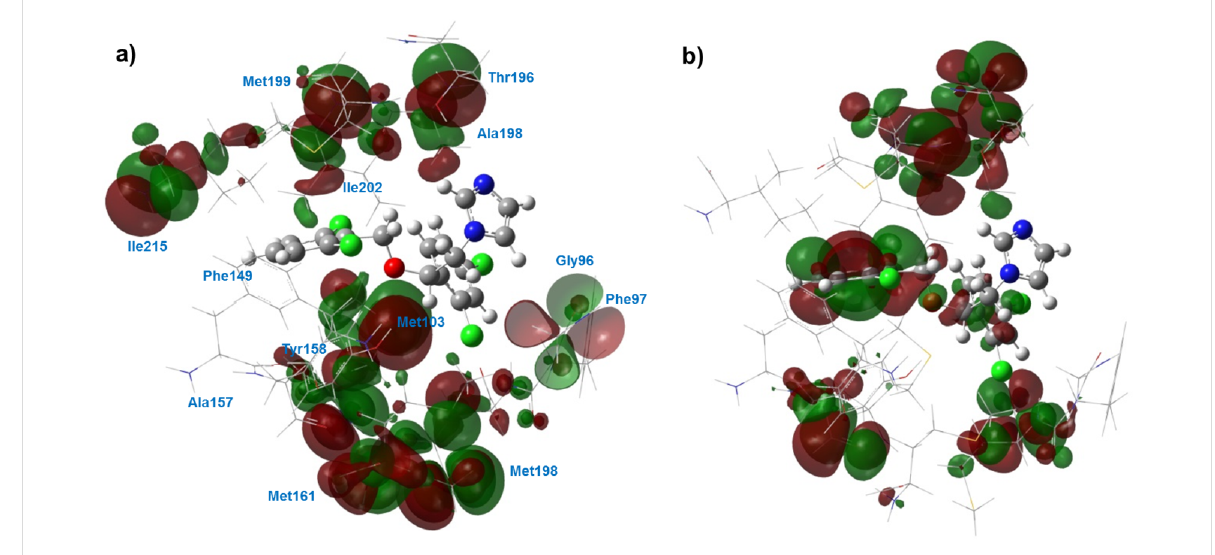
Figure 13: 3D view of HOMO (a) and LUMO (b) for the InhA active site interacting with isoconazole.